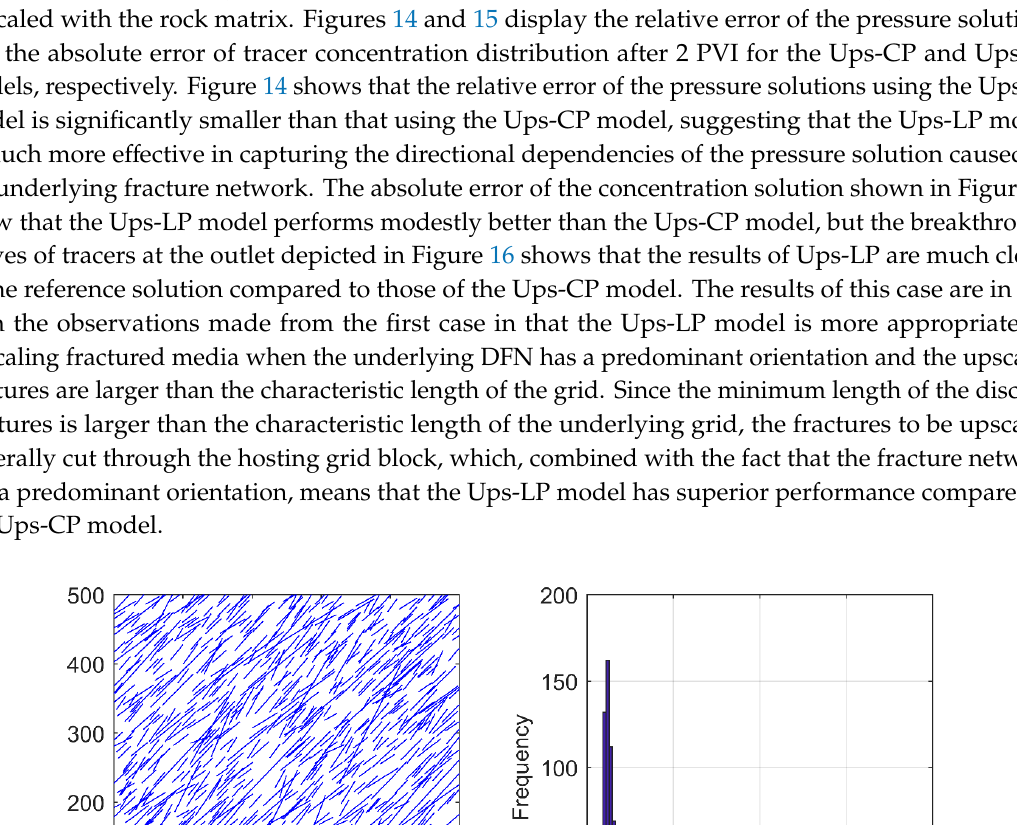
Figure 13. Upscaled permeability tensor represented by ellipses whose semi-axes are scaled by the square root of the principal values. ( Left ) Ups-CP; ( right ) Ups-LP.